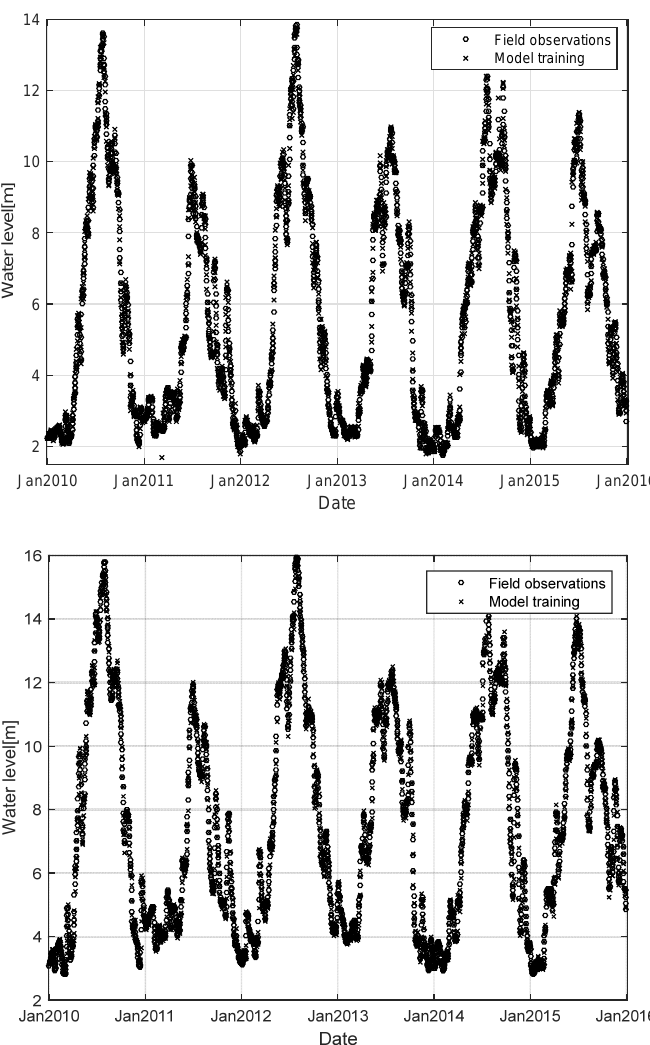
Figure 3 . LSSVMi (least squares support vector machine) model training results at Jianli station ( top panel ) and Chenglingji station ( bottom panel ).